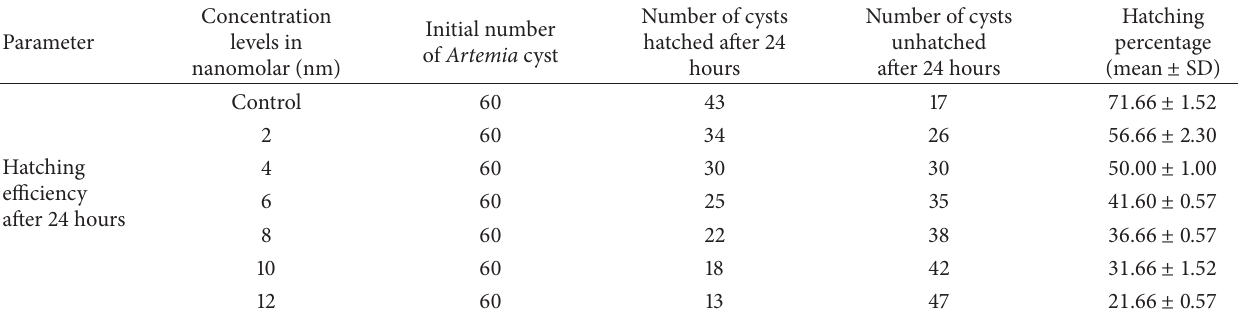
Table 2: Hatching percentage of Artemia cysts treated with various nanomolar concentrations of silver nanoparticles.